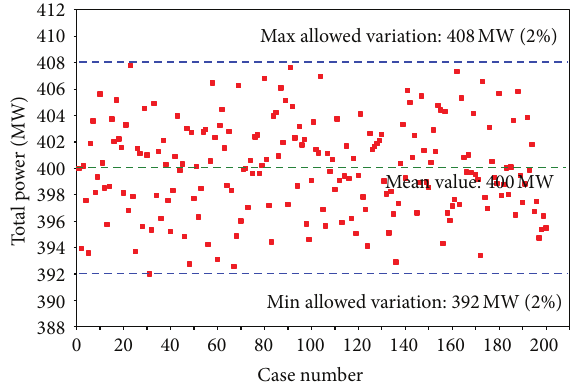
Normal distr. of par. 4, cp fuel reflNormal distr. of par. 6, cond fuel bedNormal distr. of par. 8, cond refl Normal distr. of par. 5, cp Normal distr. of par. 7, cond F 2: PDFs for the speci�c heat and thermal conductivity correlation input parameters.